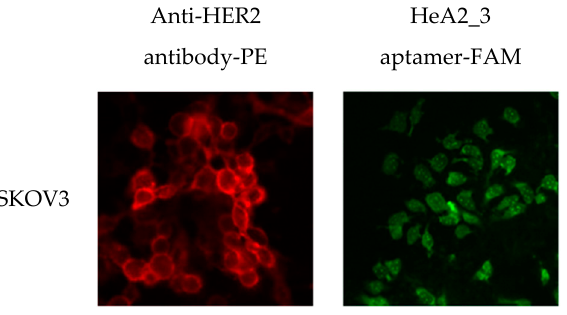
Figure 7. Fluorescence microscopy analysis of internalization of aptamer HeA2_3 into SKOV3 cells. Cultured SKOV3 cells were stained with anti-HER2 antibody ( red ) or HeA2_3 aptamer ( green ) and internalization was evaluated by fluorescence microscopy. Images were taken at a magnification of 400×. All experiments were performed at 37 °C as lower temperatures may inhibit internalization.